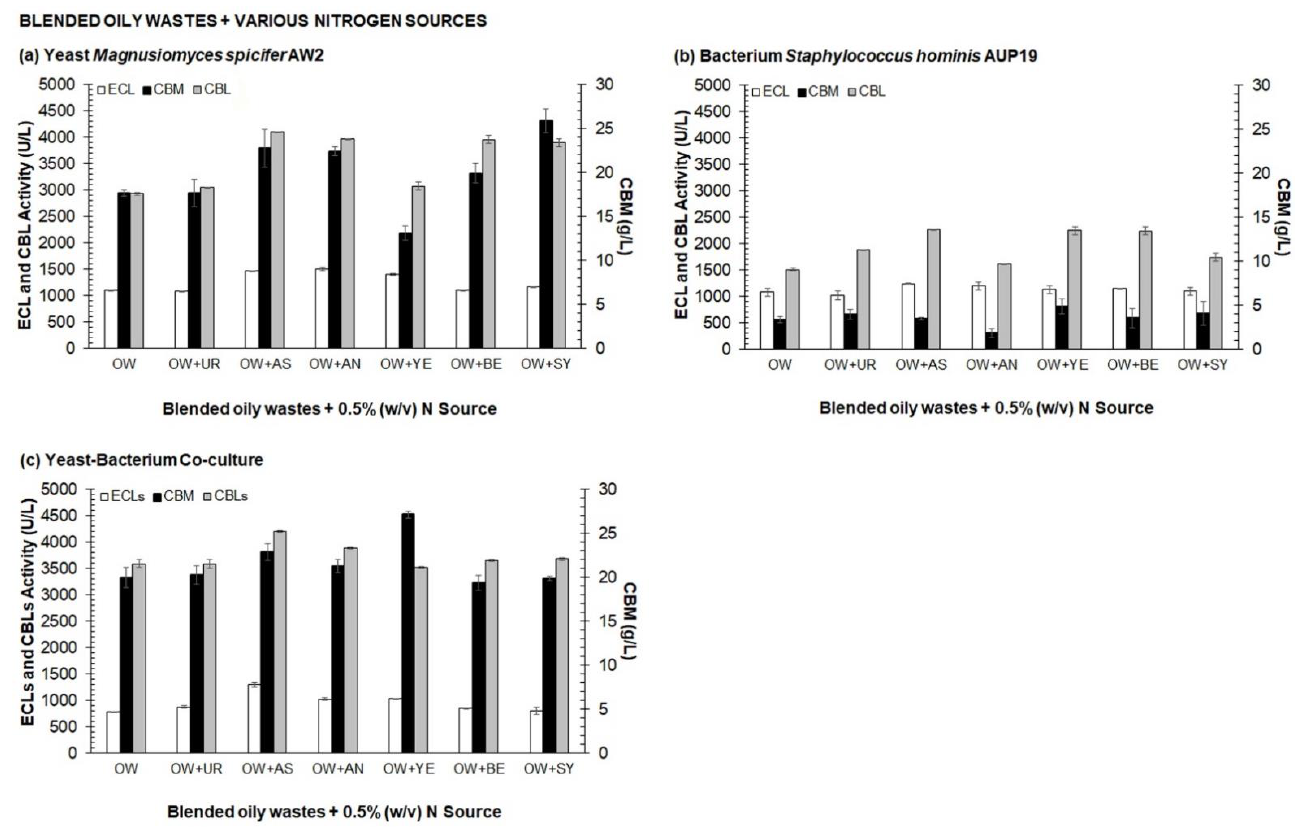
Figure 2. Selection of medium composition by one variable at a time (OVAT) for CBLs production in blended oily wastes (POME50 + 2.0% ( v / v ) WFO) + 0.5% ( w / v ) nitrogen sources, including urea (UR), ammonium sulfate (AS), ammonium nitrate (AN), yeast extract (YE), beef extract (BE), and soytone (SY) by pure M. spicifer AW2 ( a ), pure S. hominis AUP19 ( b ), and co-culture M. spicifer AW2 + S. hominis AUP19 ( c ) at room temperature (30 ± 2 °C), shaking 150 rpm for 24 h.